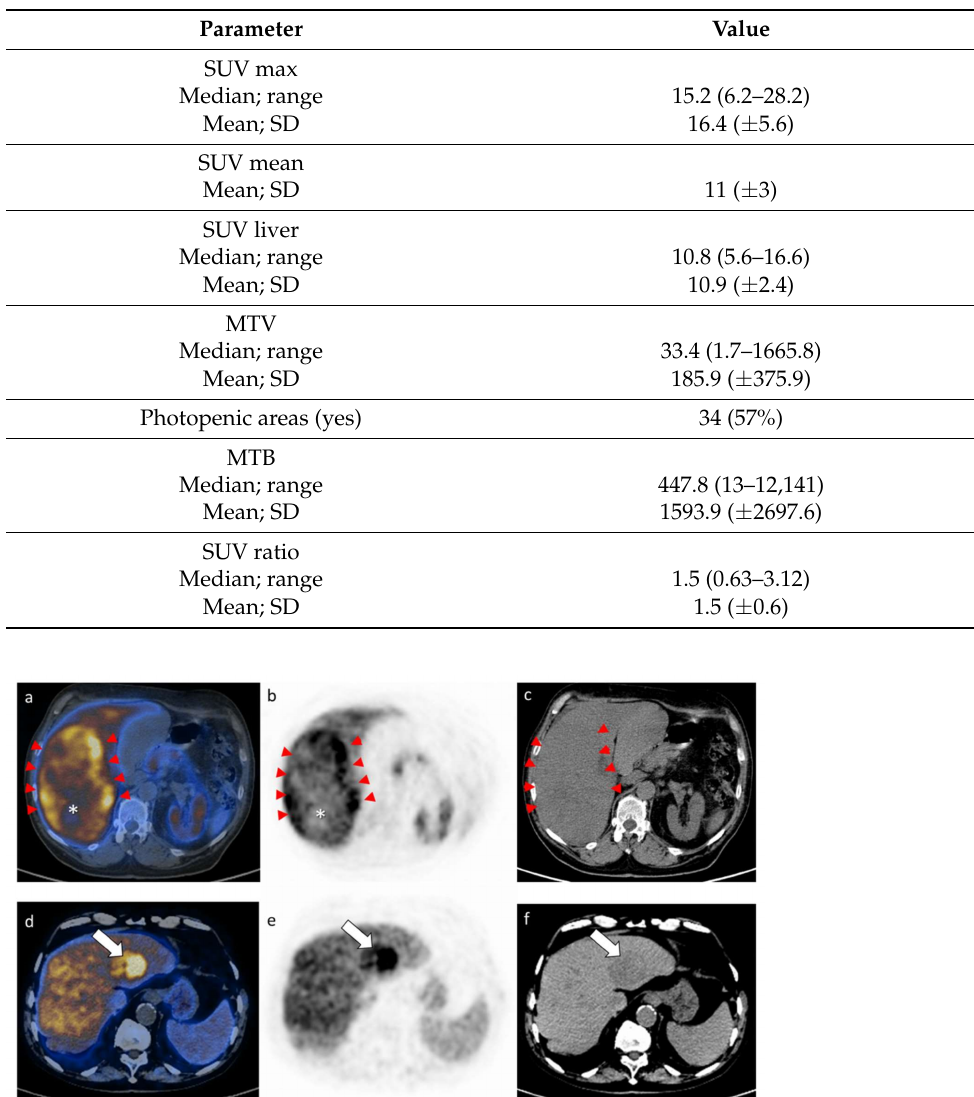
Figure 1. Illustration of two explicatory examples presenting with diverse patterns on PET images, herein shown with fused PET/CT ( a , d ), PET alone axial views ( b , e ) and low dose CT ( c , f ) at the level of the HCC lesion. The upper panels ( a – c ) represent a patient with a large HCC characterized by heterogeneous Choline uptake, mostly located in the tumor borders (red arrowheads) and associated to a clear photopenic area on the fused PET/CT and PET alone axial views ( a , b ; while asterisk). The SUVmax (maximal standardized uptake value) of the lesion resulted 25.4. The lower panels ( d – f ) represent a patient with a smaller HCC lesion characterized by an overall homogeneous and intense choline uptake, as indicated by the white arrows on all axial views. The SUVmax of the lesion herein resulted